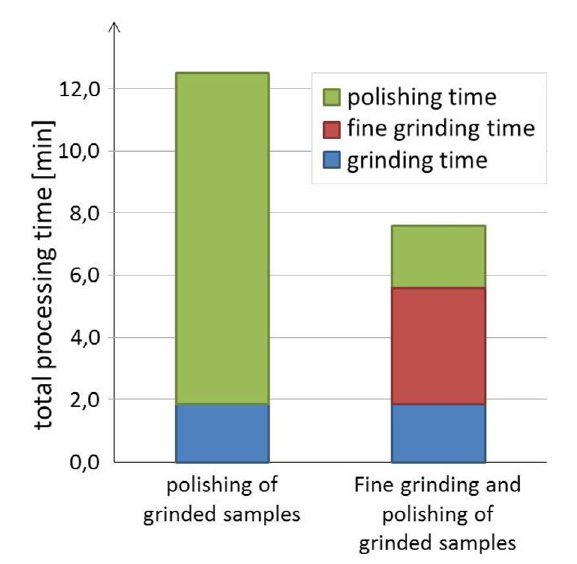
Fig. 6. Comparison of polishing time of fused silica samples by fine grinding using a resin bonded tool and samples grinded with a metallic bond D35 Tool .